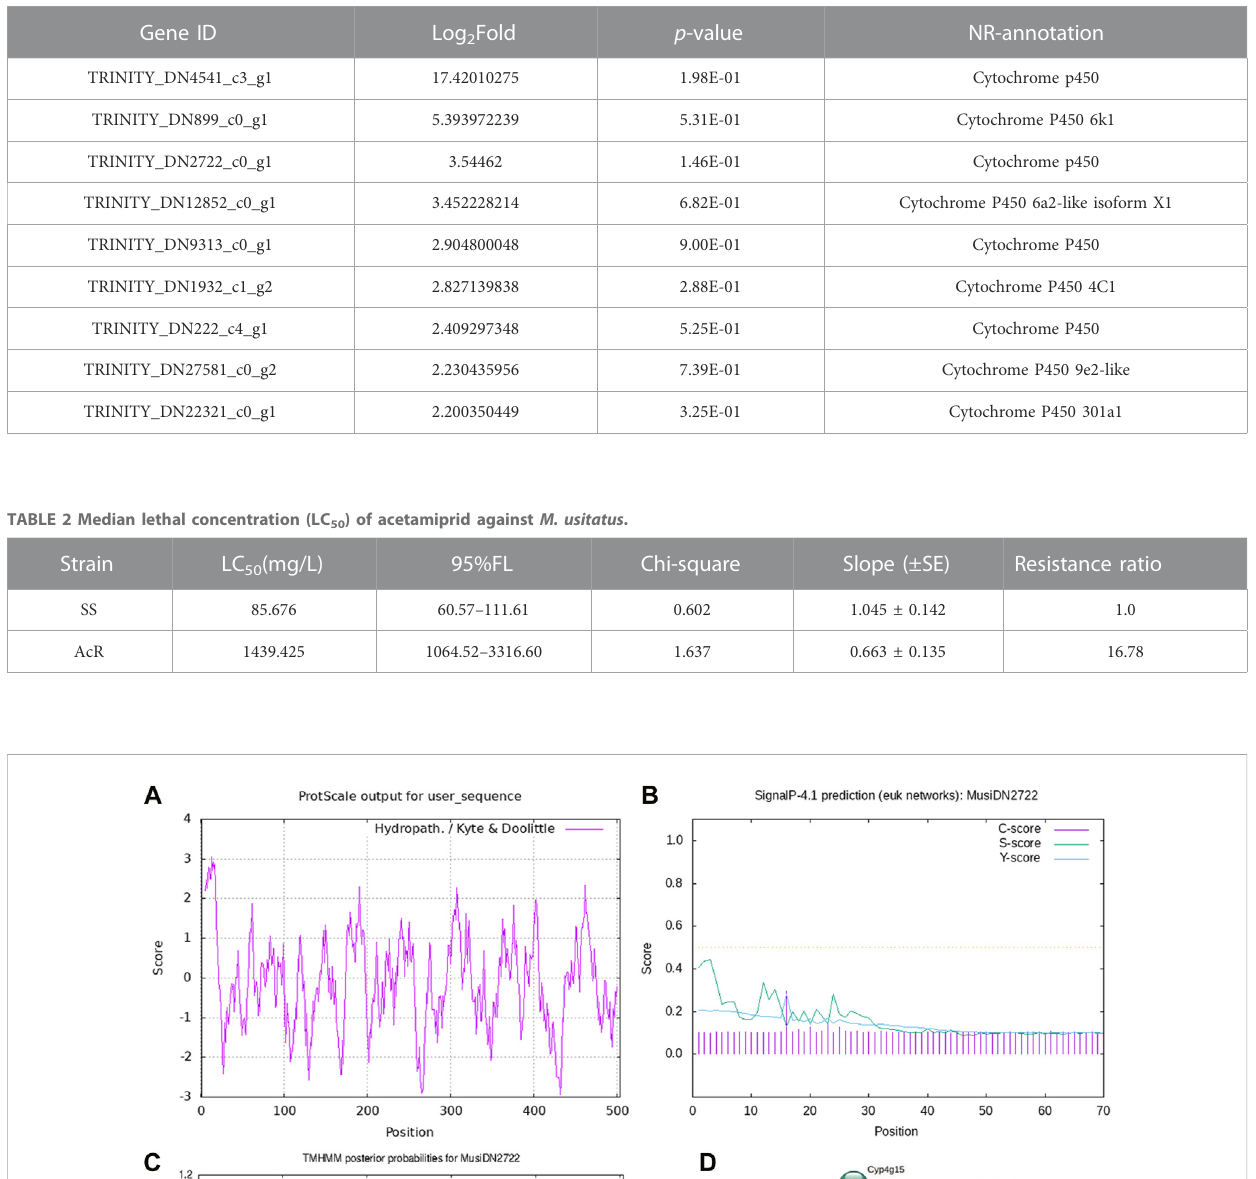
TABLE 1 Genes annotated as cytochrome P450.